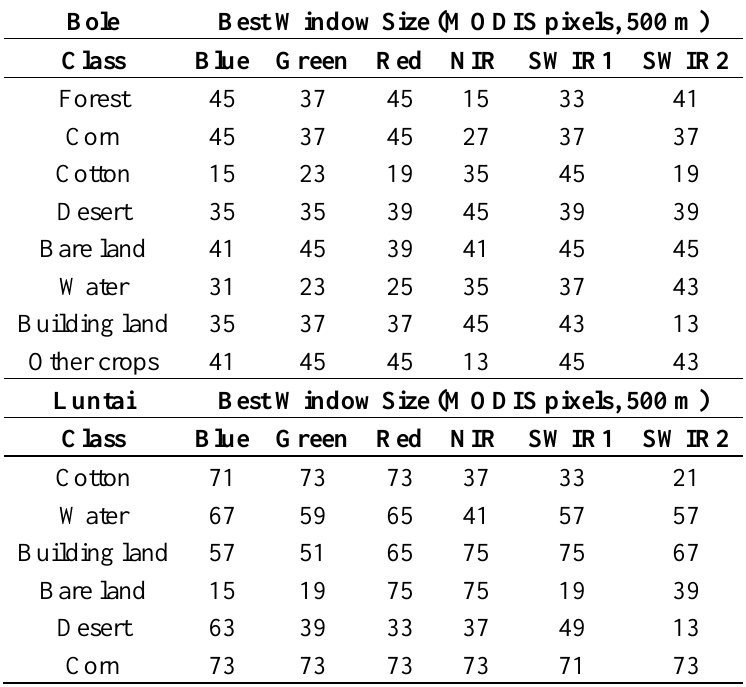
Table 3. The best window size for each band and each land